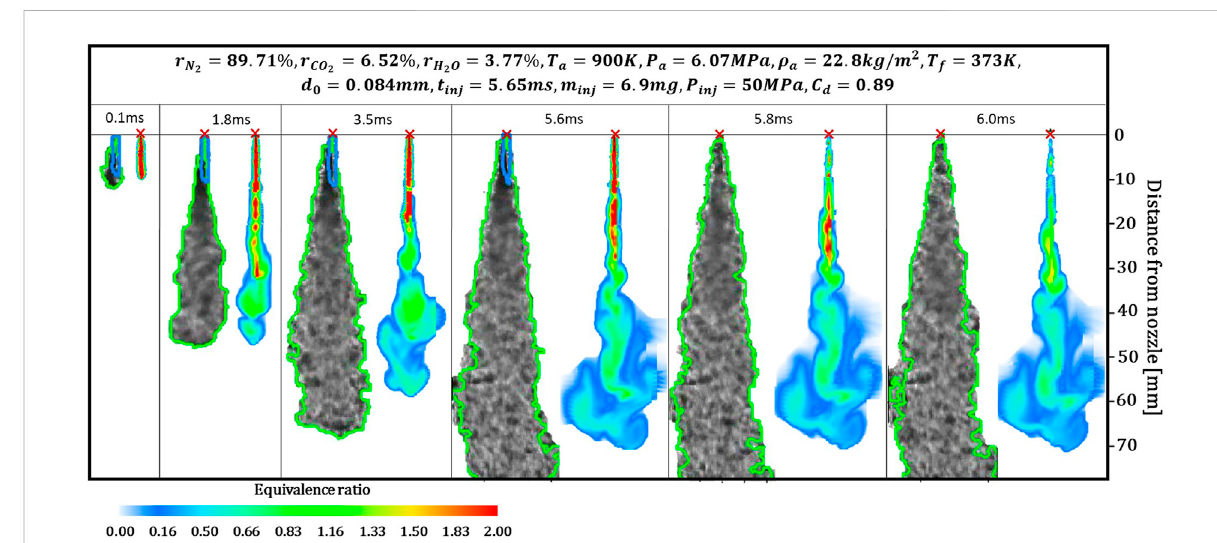
FIGURE 6 Spray shapes and equivalence ratio histories of case injection pressure: 50